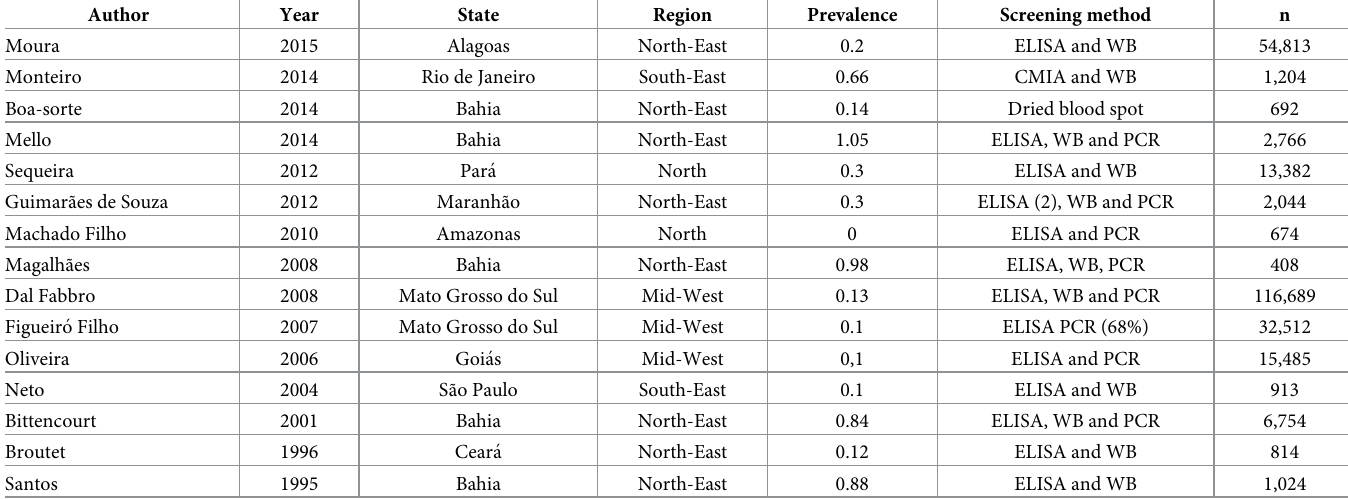
Table 2. Summary of the selected studies for the systematic review regarding the HTLV-1 prevalence in pregnant women from